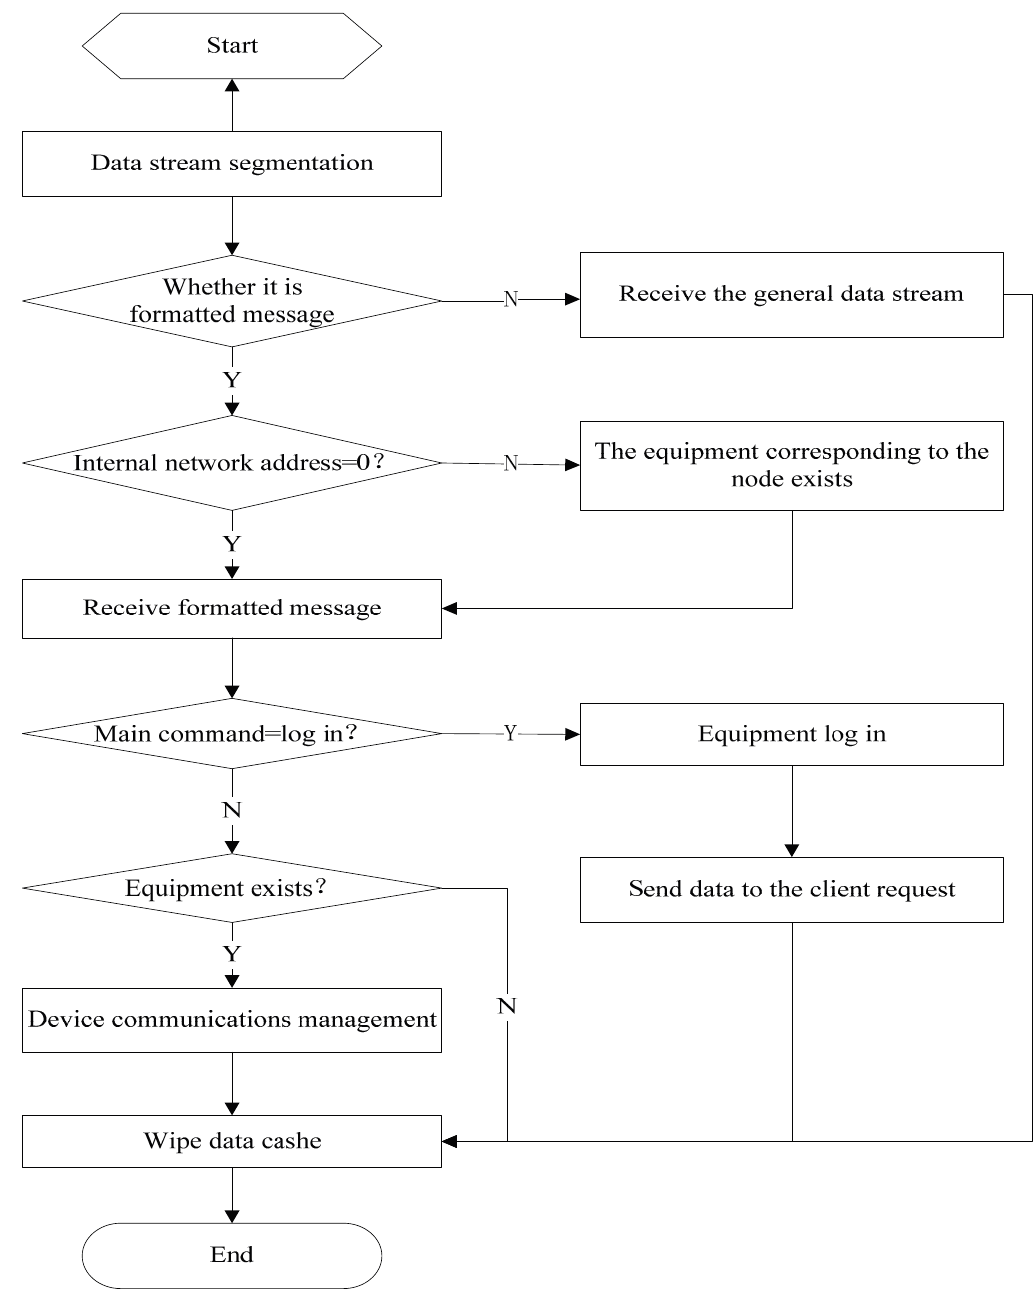
Figure 6. Data reception by the